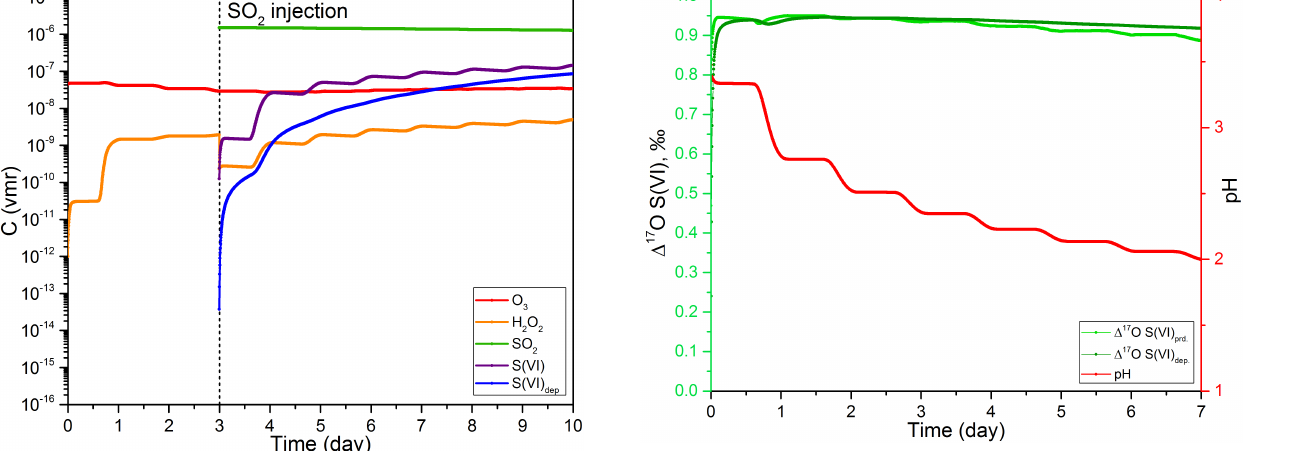
Figure 2. Evolution of the gas-phase concentrations of atmospheric species during the S1 simulation (see text). The simulation starts at 08:00 and SO 2 is injected after 3 days. During the S1 simulation the concentration of injected SO 2 drops from 1.5ppmv to a final value of 1.27ppmv.